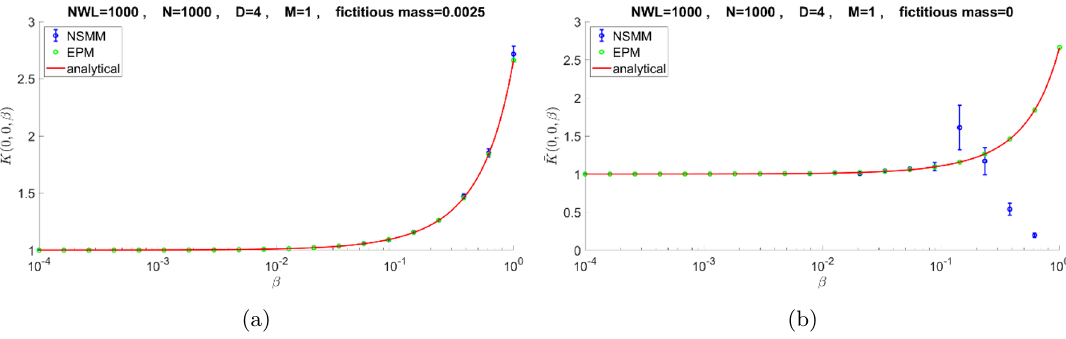
Figure 8 . Two calculations of the heat kernel of a free scalar particle on a 4-sphere with ( N WL , N ) = (1000 , 1000) and M = 1 . For the left figure, a tiny fictitious mass has been introduced ( α = 0 . 0025 ) in the WL sampling. The right figure is obtained with ( α = 0 ), i.e. no fictitious mass term. The algorithm finally reads as